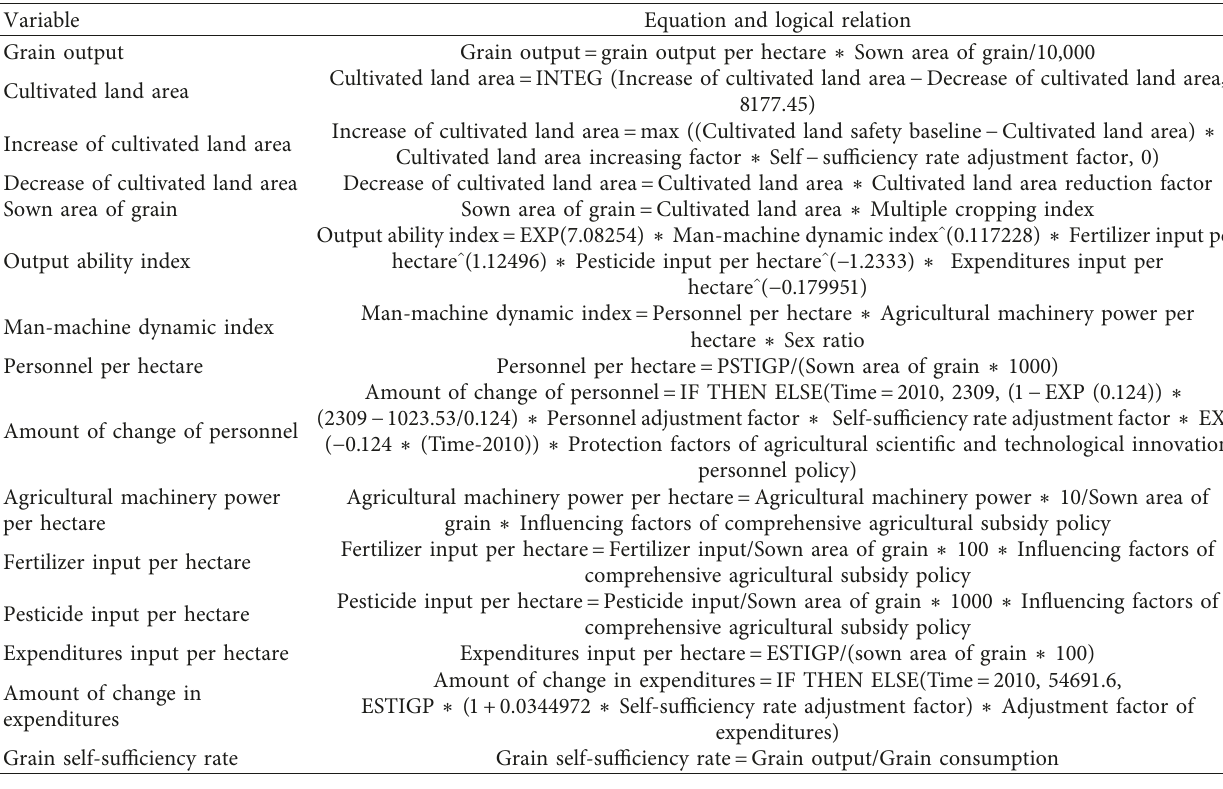
Table 1: Main equations and parameters of system model.